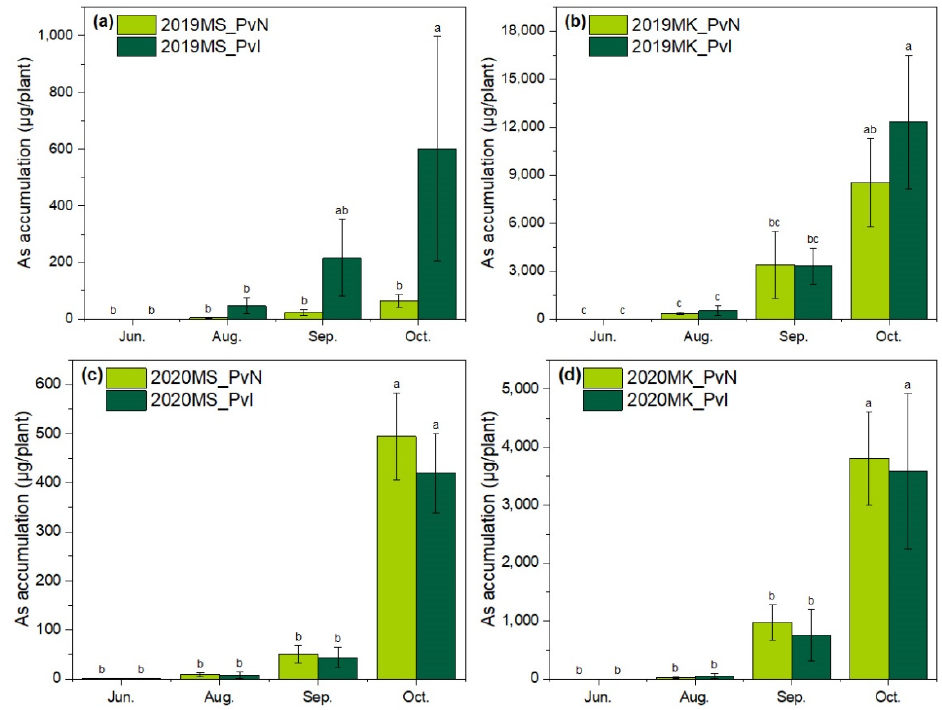
Figure 4. Arsenic accumulation in a P. vittata plant in ( a ) site MS in 2019 ( b ) site MK in 2019 ( c ) site MS in 2020, and ( d ) site MK in 2020. Data with different letters indicated significant differences ( p < 0.05) according to ANOVA by Tukey HSD